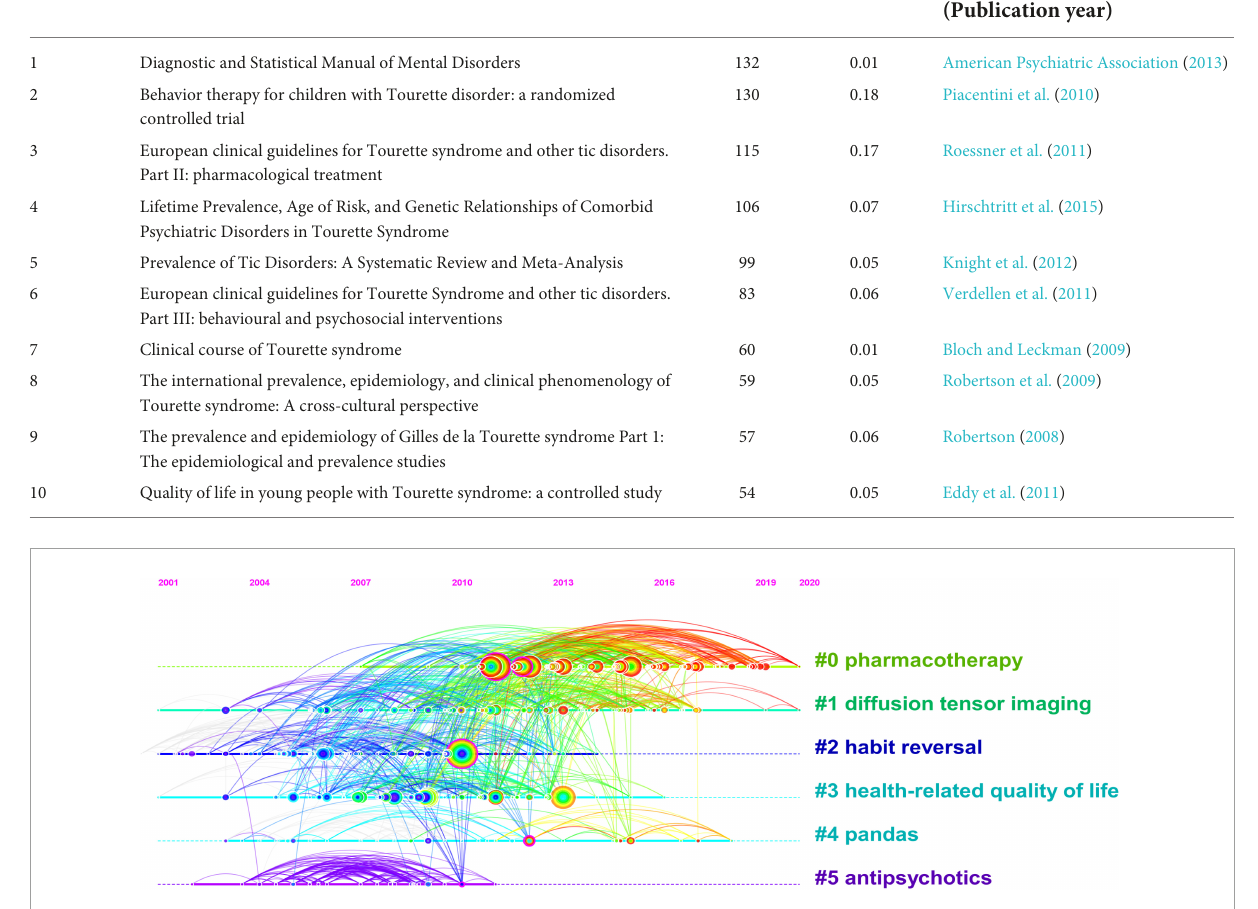
TABLE 6 The top 10 co-cited references sorted with the highest citations related to Tourette Syndrome (TS) in children research from 2011 to 2021. Ranking